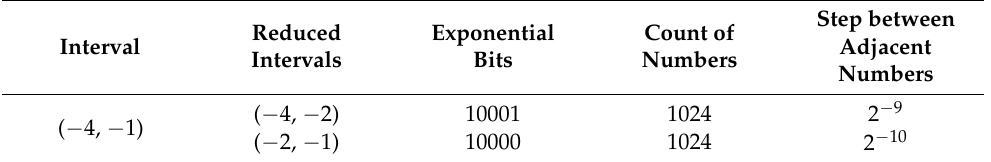
Table 3. ELU function to calculate the interval of ( − 4, −